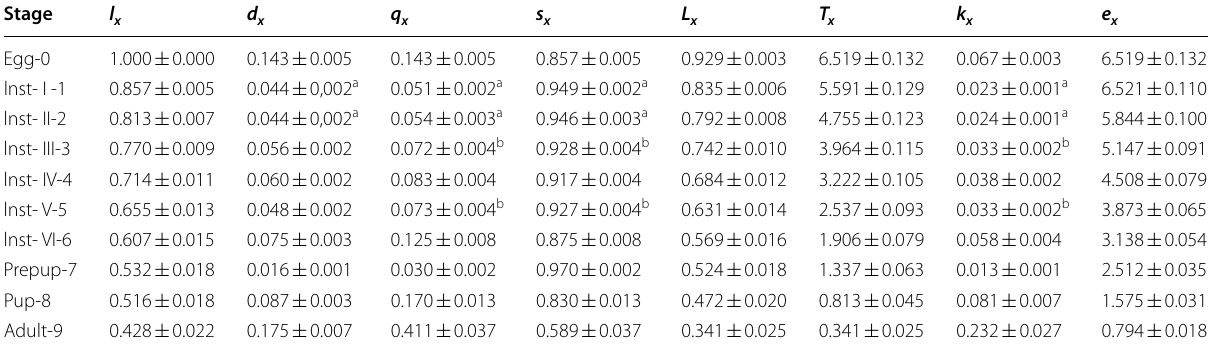
Within the column means followed by same letter(s) are not significantly different at P < 0.05 by Tukey’s (HSD) test